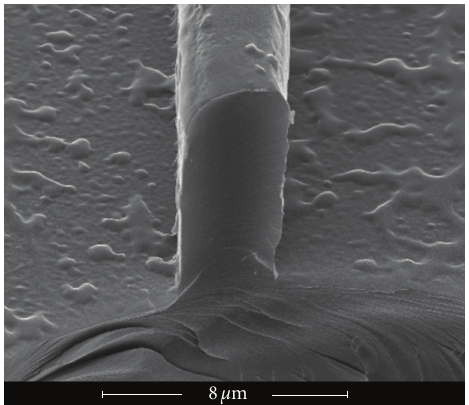
Figure 6: SEM image showing the cleaved end of an optical waveguide. As can be seen, the cut is quite clean, however, it is not perfectly perpendicular to the waveuide nor is it perfectly flat, and in addition there are some minor scratches in the waveguide. All of these features have an impact on the outcoupling of light from the waveguide and all of them can di ff er from waveguide to